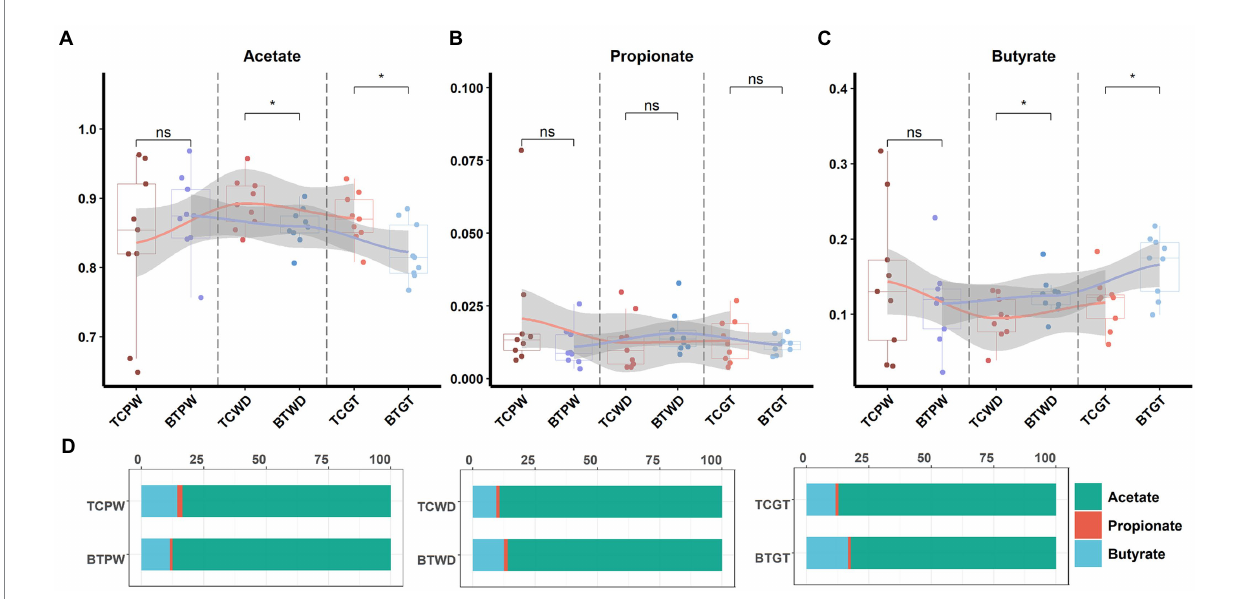
FIGURE 11 The tendency of acetate, propionate, and butyrate by stages: (A) the pre-weaning stage, (B) the weaned stage, and (C) the growth stage. Each point represents a sample, and differences in the figures were marked by “ns,” “*,” and “**” while no significance, p < 0.05 and p < 0.01, respectively. (D) Ratios of acetate, propionate, and butyrate by stage.